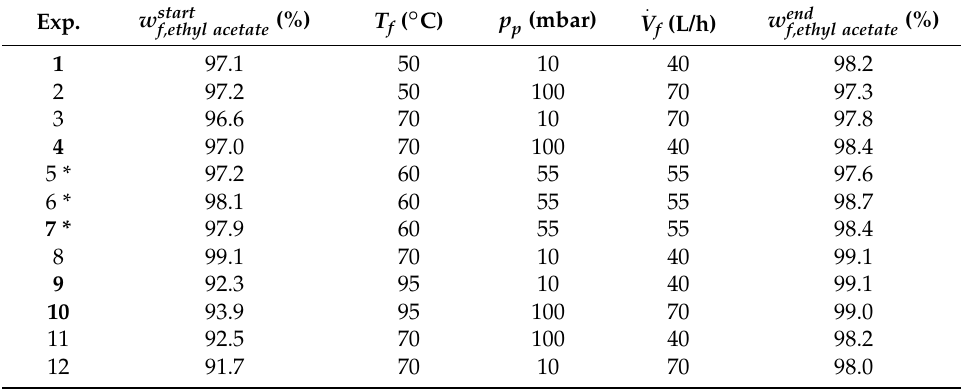
Table 3. Experimental design for the binary system ethyl acetate/water. Indicated (*) experiments represent the centre point experiments. Bold highlighted experiments were used for the determination of the permeance, the rest for the validation of the model. All experiments were conducted with feed pressure of 3.5